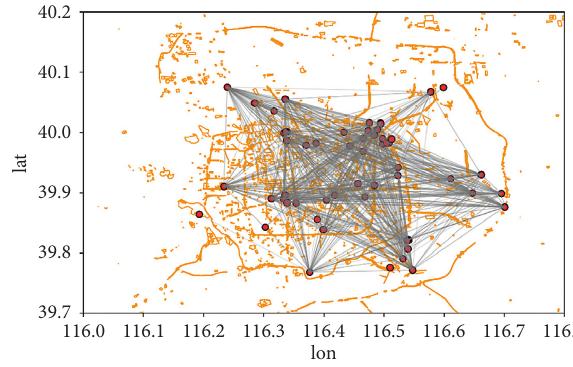
Figure 4: Rental records between any two